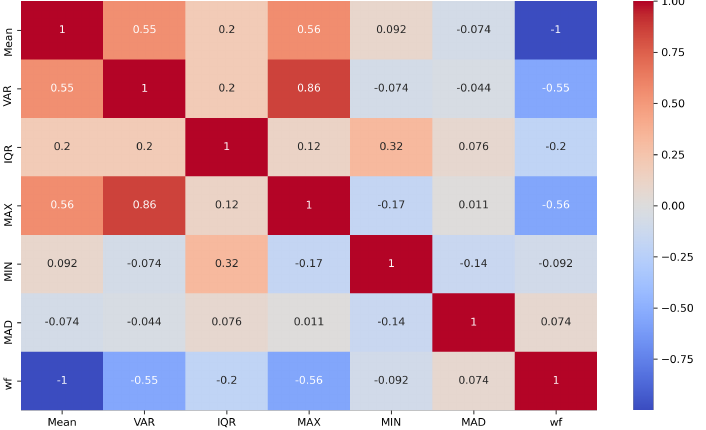
Figure 13. Feature selection plot for the Impedance